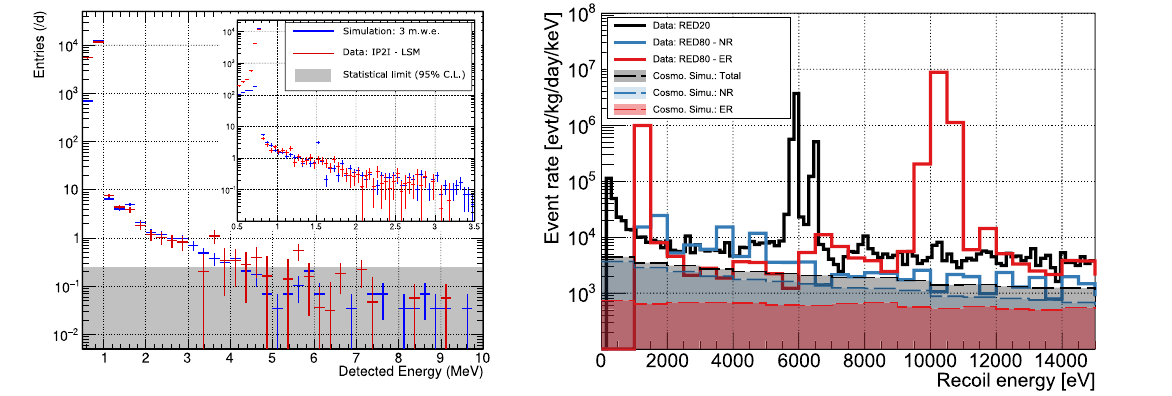
RED80 [14] low-threshold cryogenic detectors, operated in the IP2I cryostat surrounded by a 70% coverage 10 cm thick lead shielding, and its resulting cosmogenic background simulation. For both the sim- ulation and the RED80 data, we show the nuclear (blue) and electronic (red) recoil components, as well as the total expected cosmogenic back- ground at IP2I (black dashed curve). Note that the remaining internal and external radioactivity from the surrounding materials are not taken into account here. For the sake of clarity, error bars are not shown but are about 10% [32] and 30% [14] for the RED20 and RED80 data,